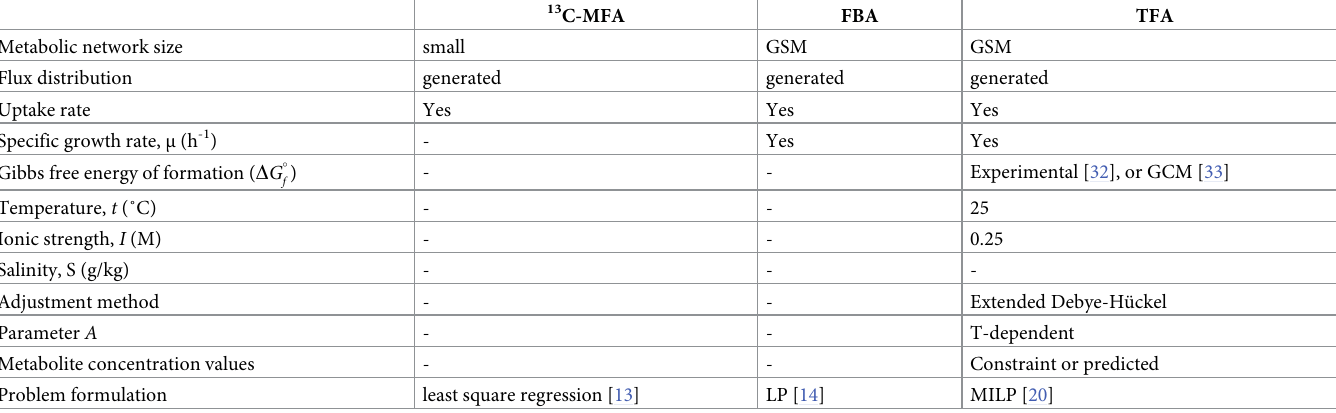
Table 1. Comparison of frequently used approaches in fluxomics. Parameter A is used in the extended Debye-Hu¨ckel